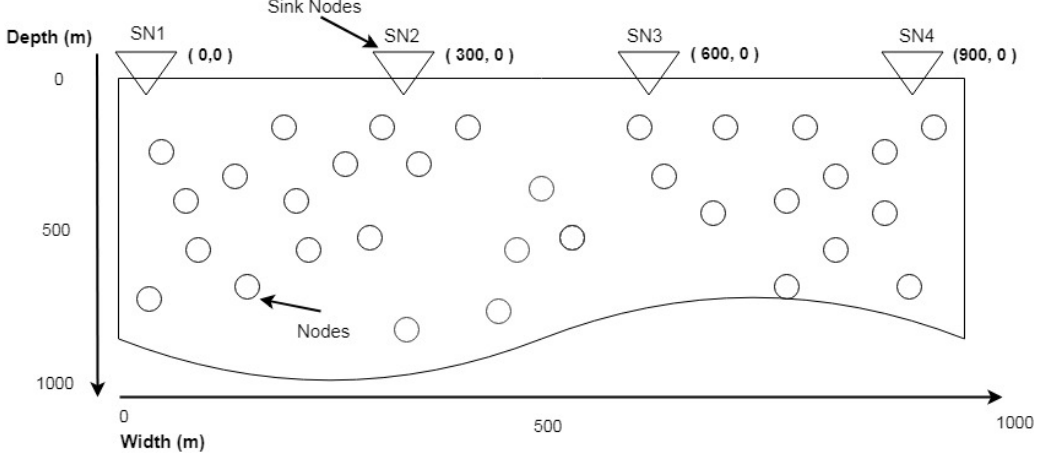
Figure 2. Finding X axis Location.